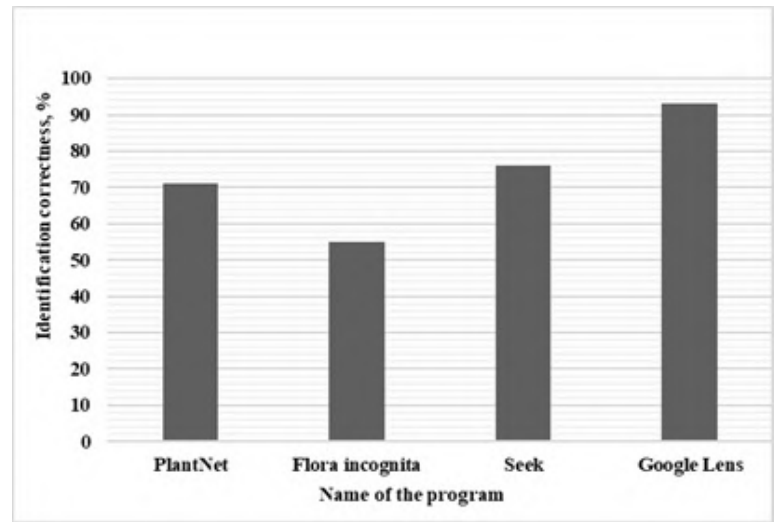
Figure 9: Results on analysis quality of apps which is identified